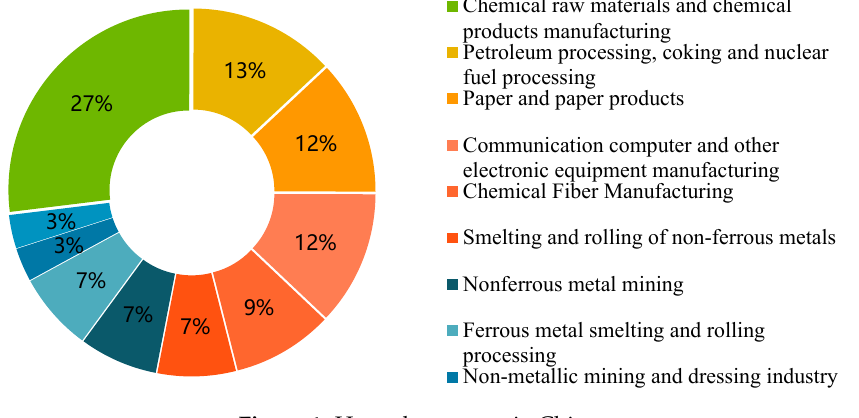
Figure 1. Hazardous waste in China.